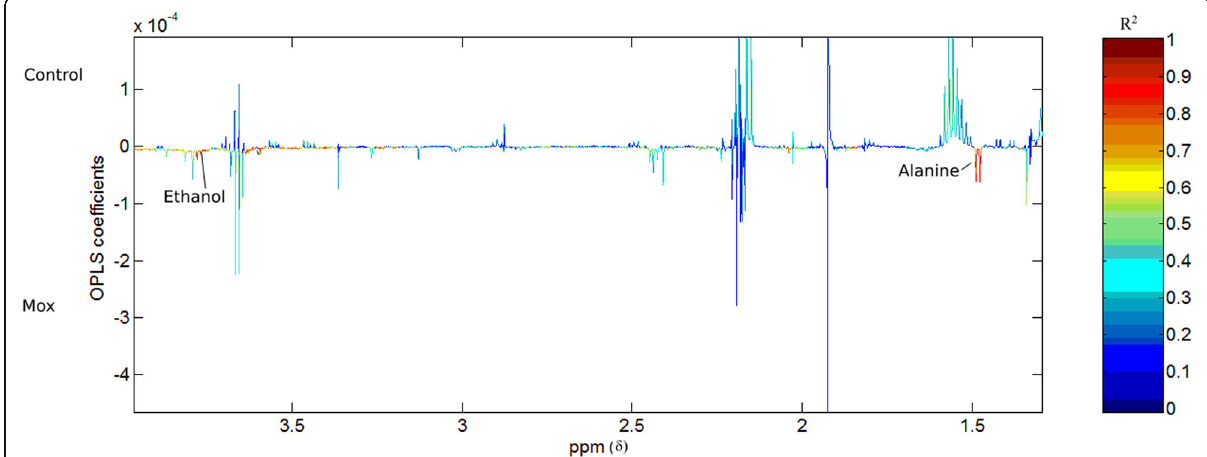
Fig. 4 The correlation coefficient plot from the OPLS-DA model built with the metabolic profiles of samples from the fermentations of faeces collected 16 h after moxidectin administration ( R 2 = 0.69, Q 2 Y =